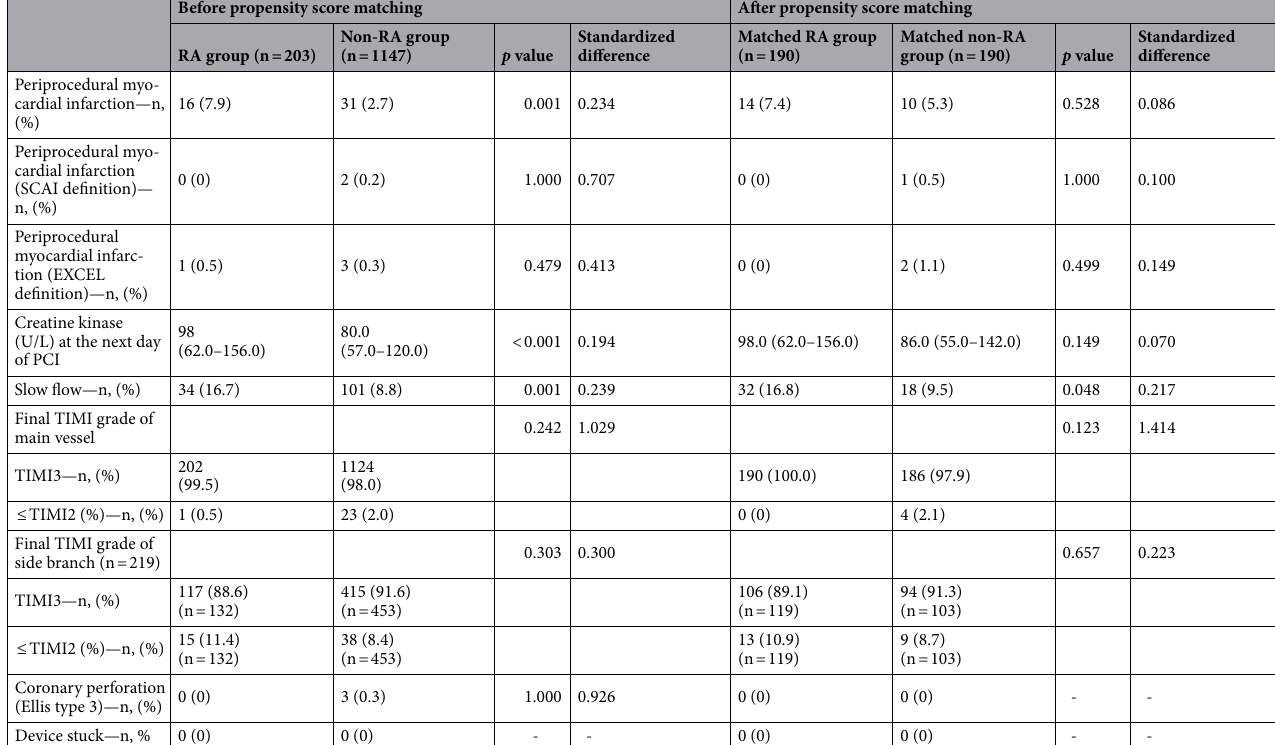
Table 2. Comparison of complications between the RA and non-RA groups before and after propensity score matching using the match tolerance set as a width of 0.30 multiplied by the SD of the propensity score